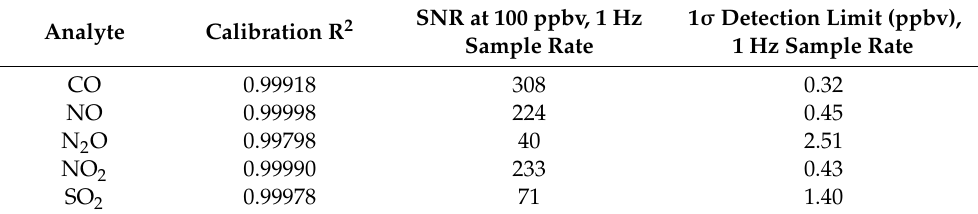
Table 2. Linear response and detection limits derived from the calibration for the individual target analytes.